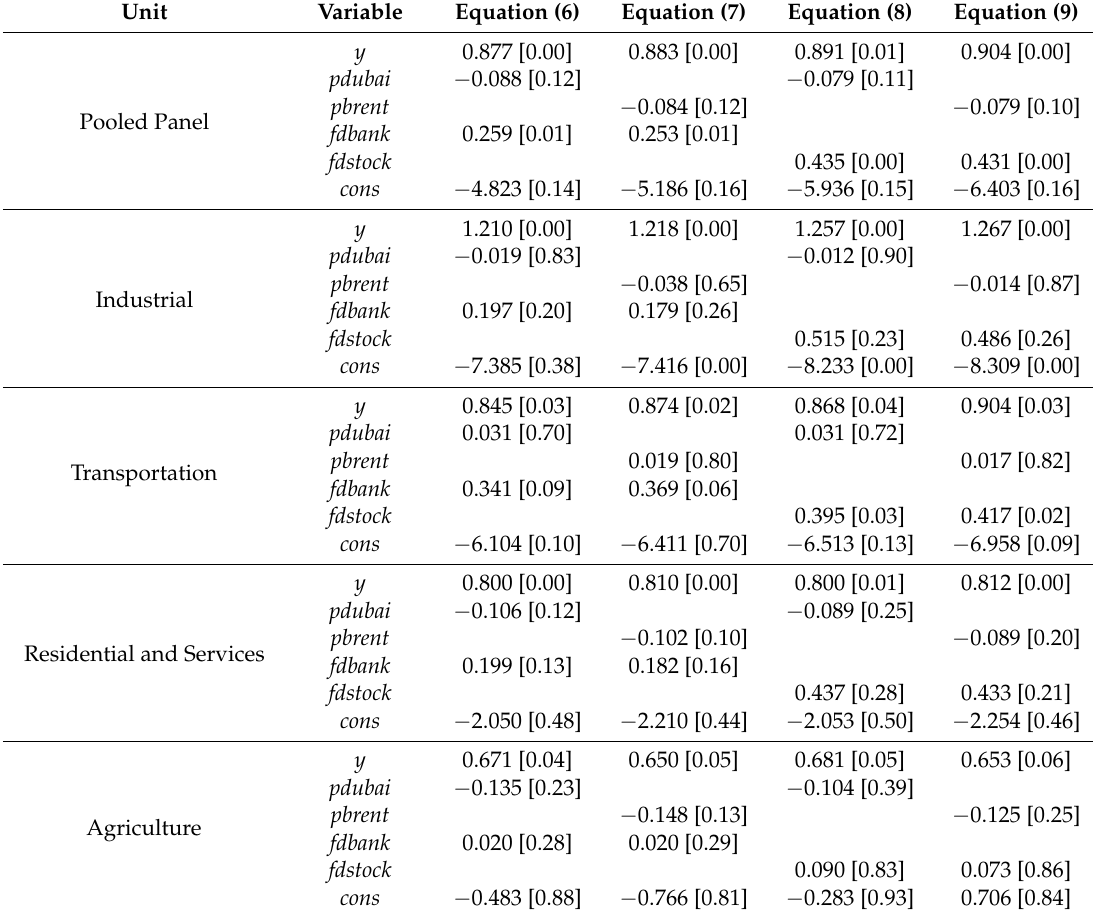
Table 6. MG results based on linear